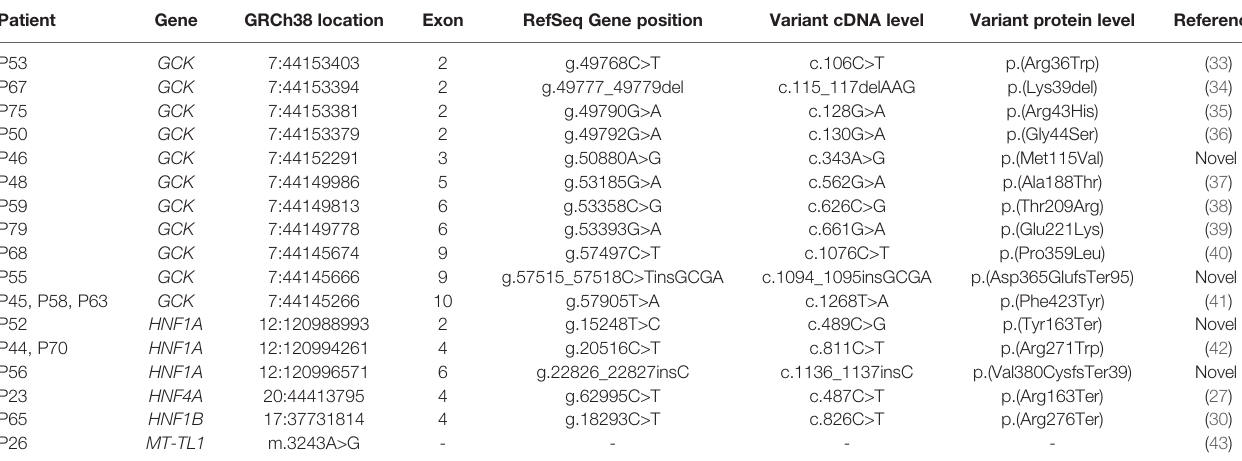
TABLE 2 | Variants identi fi ed in the Brazilian sample described by our